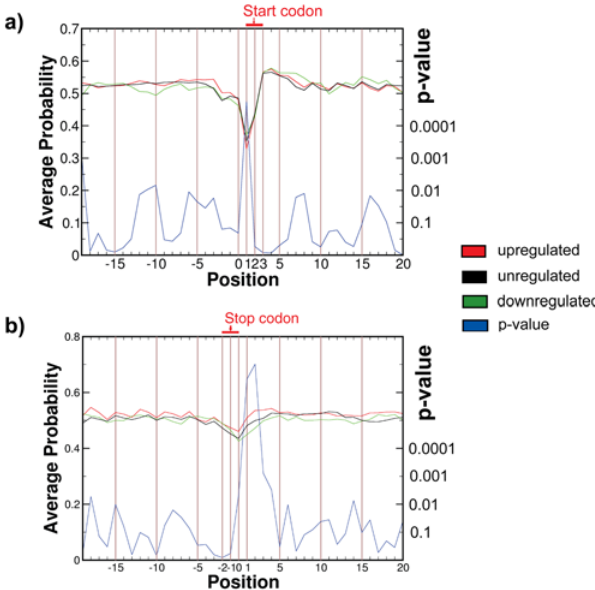
Figure 2. Probability of base pairing is greater for upregulated mRNAs at the regions just upstream of the start codon and flanking the stop codon. Secondary structure profiles of mRNA regions. Red, black, green: average secondary structure probability for upregulated, un-regulated or downregulated mRNAs respectively; blue: p-value of the Wilcoxon-Mann-Whitney two-sample rank sum test using logarithmic scale shown on the right y-axis. a) start codon (positions 2 19…20 with position 1 being the first nt of the coding region), b) stop codon (positions 2 19…20 with position 1 being the first nt of the 3 9 UTR).The positions of start and stop codon are indicated in red. The used subsets of the eIF4E overexpression data consists of 1835 upregulated mRNAs, 679 downregulated mRNAs and 3814 nonregu- lated mRNAs (see Material and Methods).